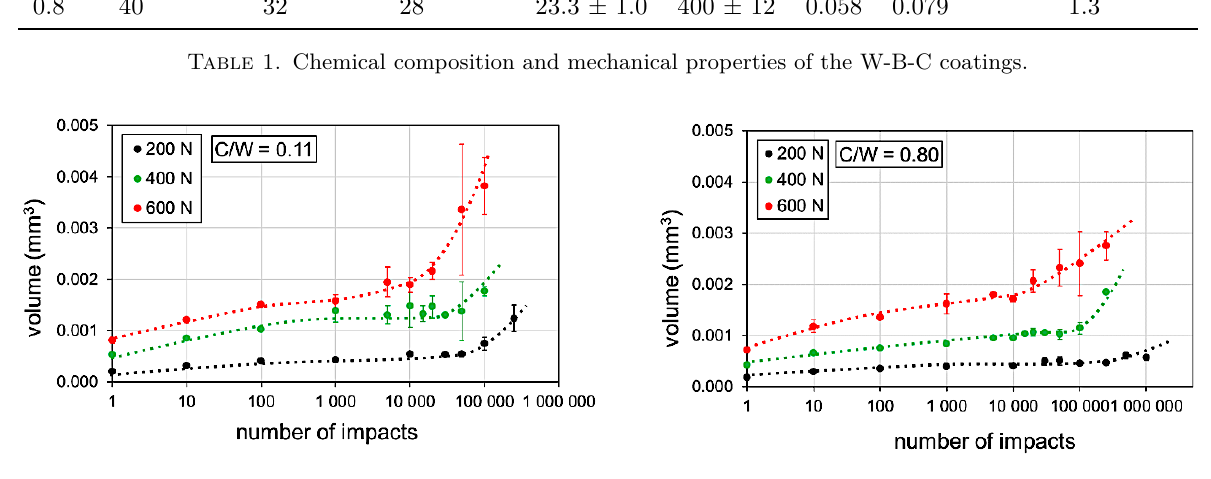
Figure 1. Loading curves of the W-B-C coatings. Dotted lines were added as a visual